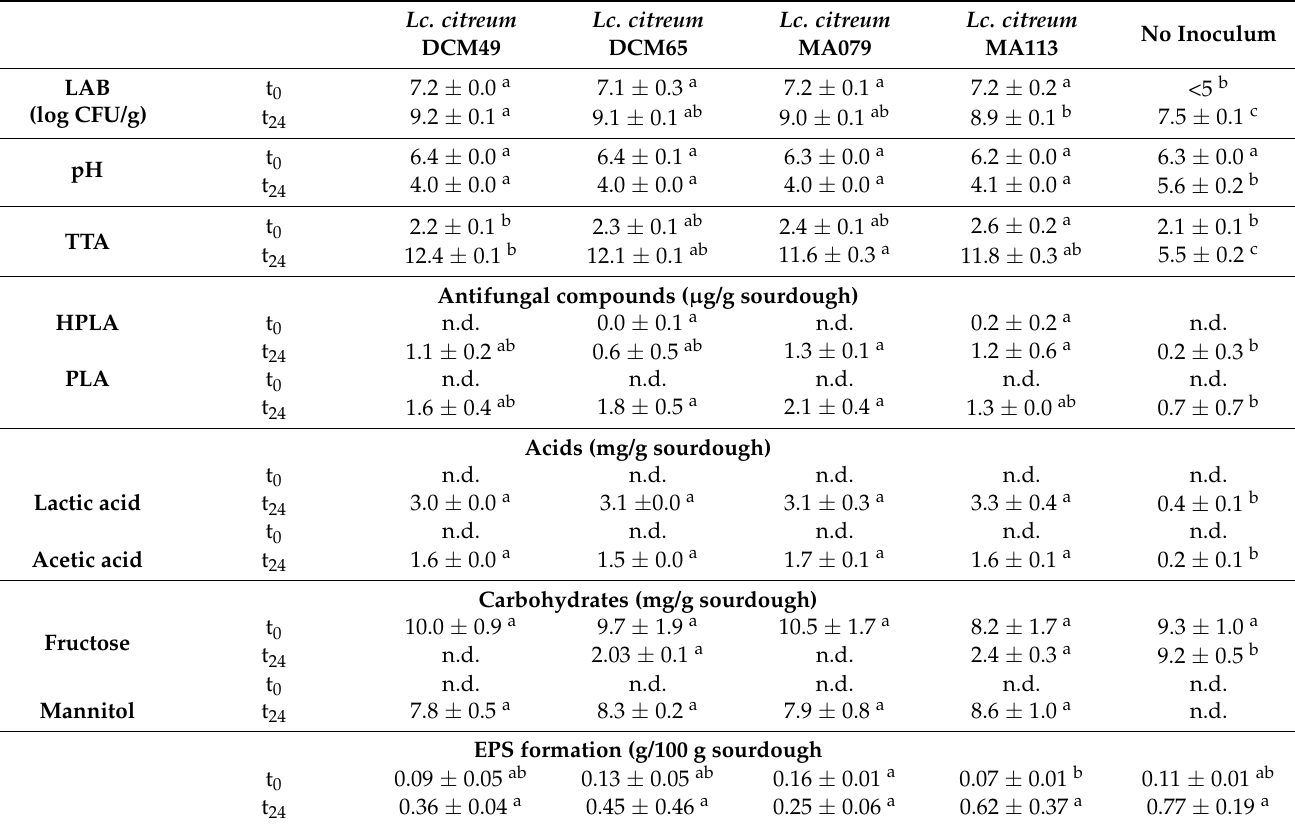
Table 7. Cell counts, pH, TTA, antifungal compounds, acids, fructose, mannitol, and EPS in lab-Scheme 400 g, 30 ◦ C, 24 h) inoculated with four Lc. citreum strains and a spontaneously fermented sourdough without inoculation at t 0 (before) and t 24 (after fermentation for 24 h at 30 ◦ C). Given values are average values ± standard